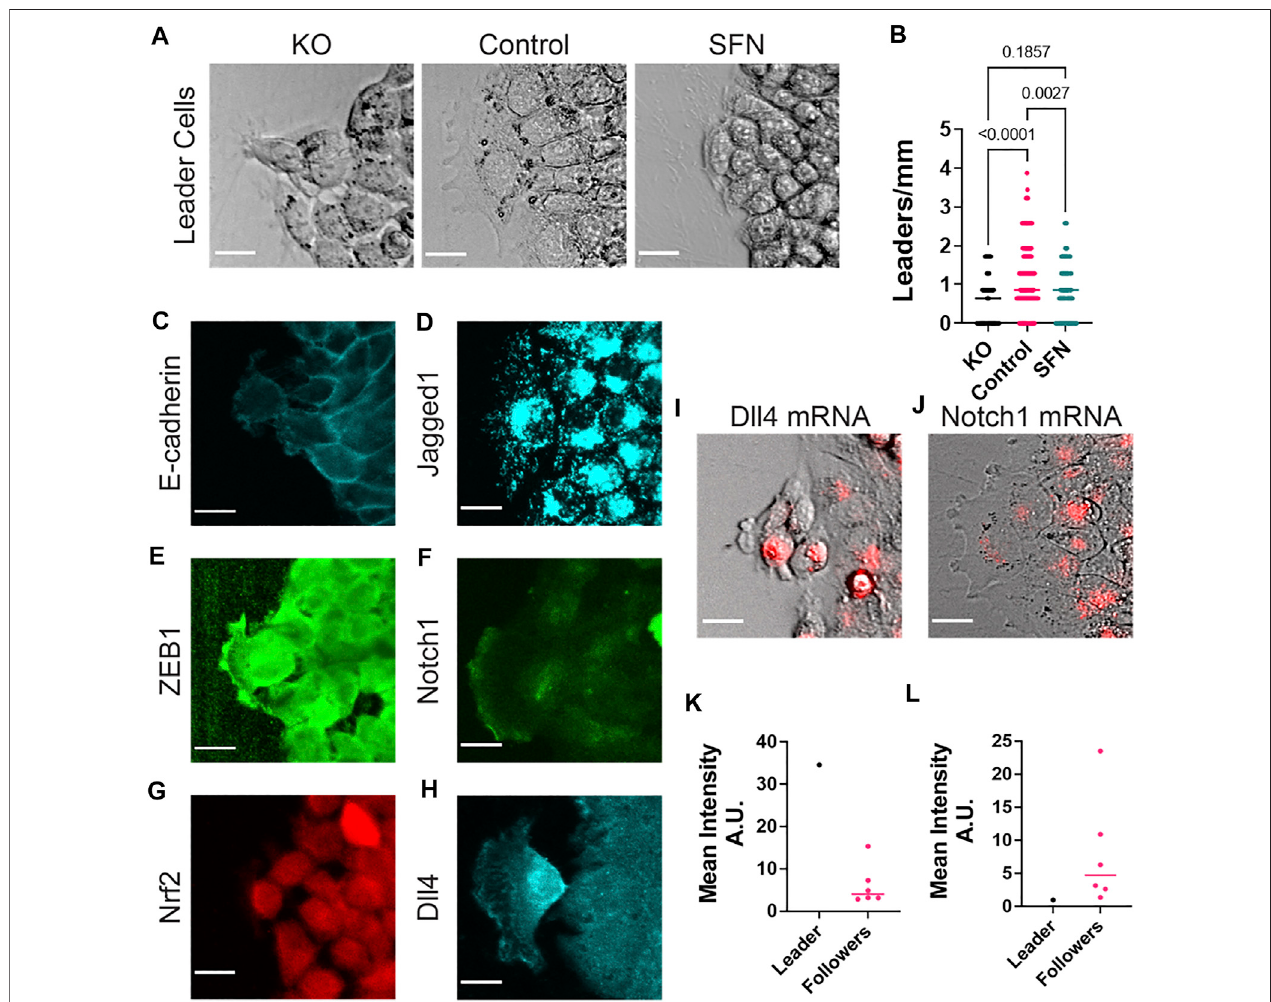
FIGURE 6 | Leader cell formation at the leading edge. (A) Representative bright- fi eld images of leader cells after a 24 h cell migration assay for CRISPR/ Cas9 NFE2L2-KO Pool RT4 cells (KO), RT4 cells (Control) and sulforaphane treated (7.5 μ M, 24 h) RT4 cells (SFN), respectively. (B) Plot showing leader cells per millimeterforCRISPR/Cas9NFE2L2-KOPoolRT4cells(KO),RT4cells(Control)andsulforaphanetreatedRT4cells(SFN),respectively.One-wayANOVAwith post-hoc Tukey ’ s test was used to compare across groups and the ROUT method was used to identify outliers (KO n = 46, Control n = 100, SNF n = 86 leading edges). (C – H) Representative immunocytochemistry images of leader cells in the control case (RT4 cells) characterizing gene expression for (C) E-cadherin, (D) Jagged1, (E) ZEB1, (F) Notch1, (G) Nrf2, (H) Dll4. (I , J) Representative overlay images using the dsLNA biosensors to measure mRNA levels of (I) Dll4 and (J) Notch1, respectively. (K , L) Mean intensity of leader vs. follower cells for levels of (K) Dll4 mRNA ( n = 6 follower cells) and (L) Notch1 mRNA ( n = 6 follower cells). (K , L) represent the quanti fi cationofoneleadercellanditsfollowercells.Immunocytochemistrydataarefromfourexperiments,anddsLNAbiosensordataarefromthreeexperiments.Scale bars, 20 μ m.